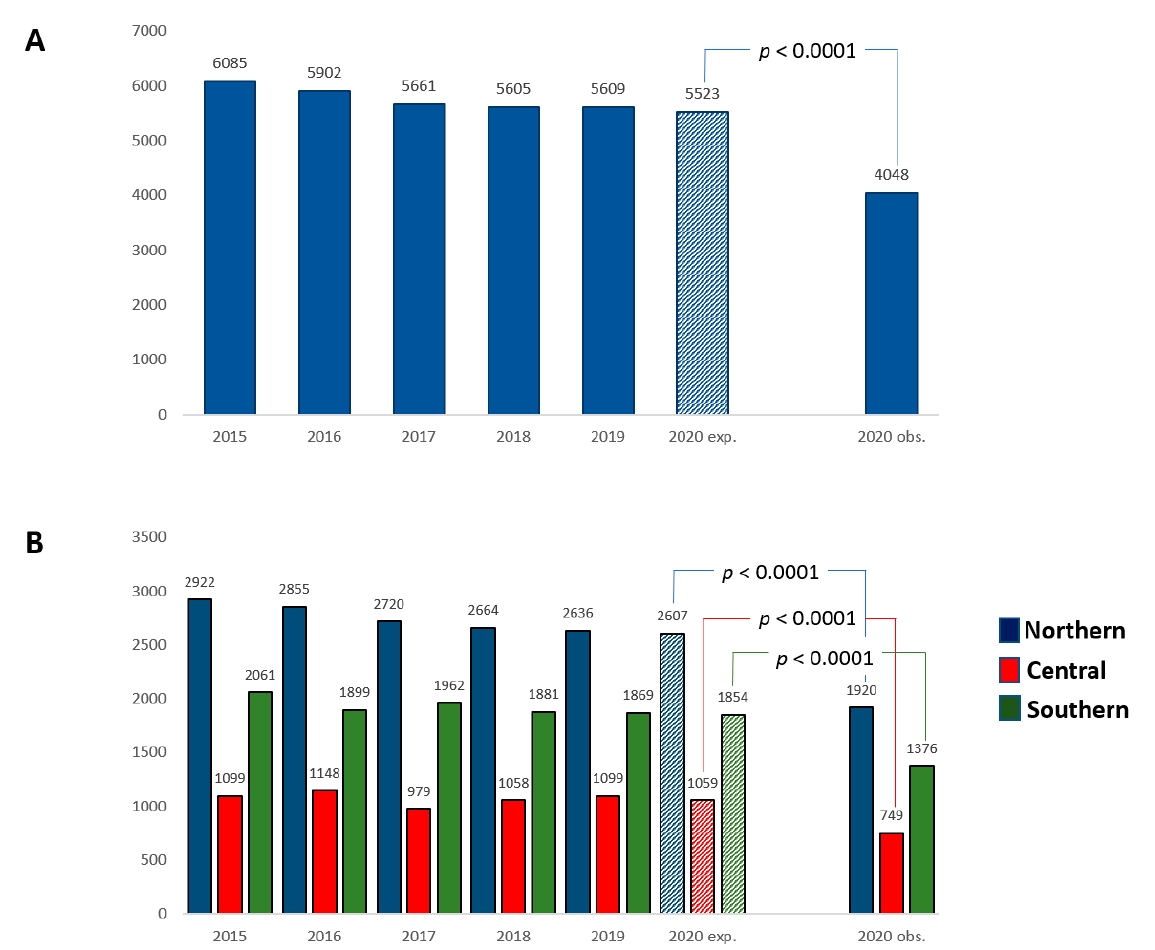
Figure 1. Expected (exp.) and observed (obs.) incidence of STEMI admission during the 2020 national outbreak and over the equivalent periods in the previous 5 years in Italy ( A ) and by geographic regions ( B ).